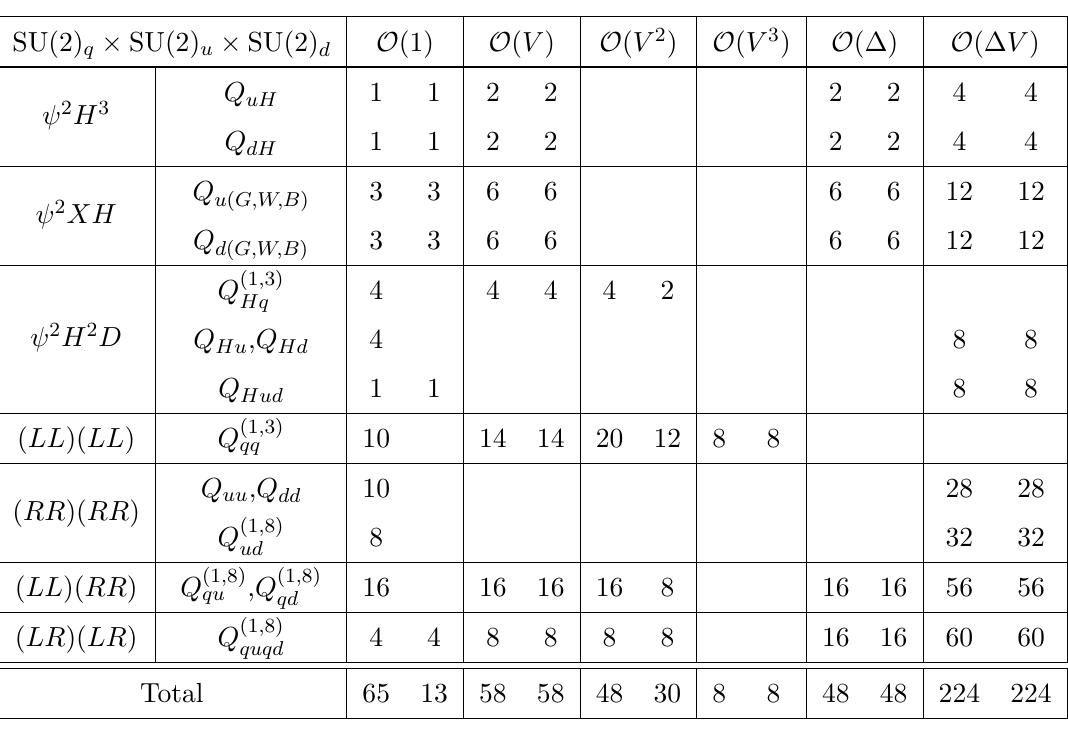
Table 3 . Counting of the pure quark SMEFT operators (see appendix A) assuming SU(2) q × SU(2) u × SU(2) d symmetry in the quark sector. The counting is performed taking up to three insertions of the V q spurion, one insertion of ∆ u,d and one insertion of the ∆ u,d V q spurion product. The left (right) entry in each column gives the number of CP even (odd) coefficients at the given order in spurion counting. Due to the presence of the additional SU(2) structures in the decompositions, the counting is different compared to table